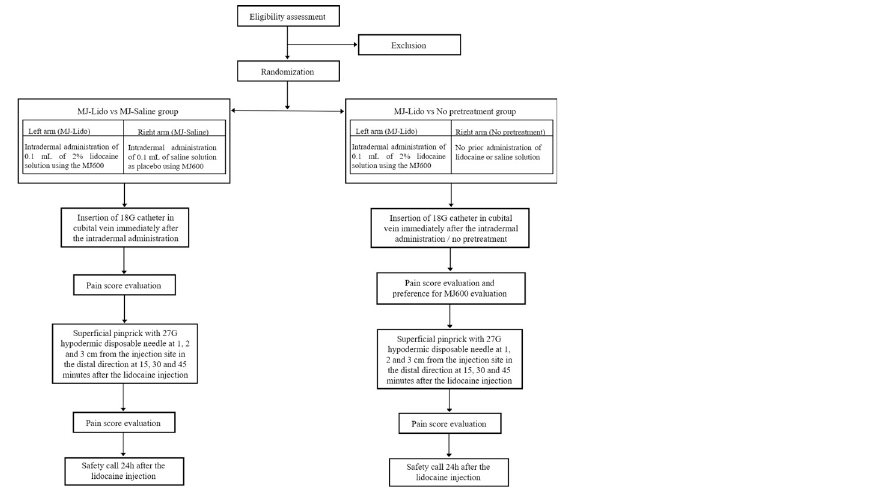
Fig 3. General study